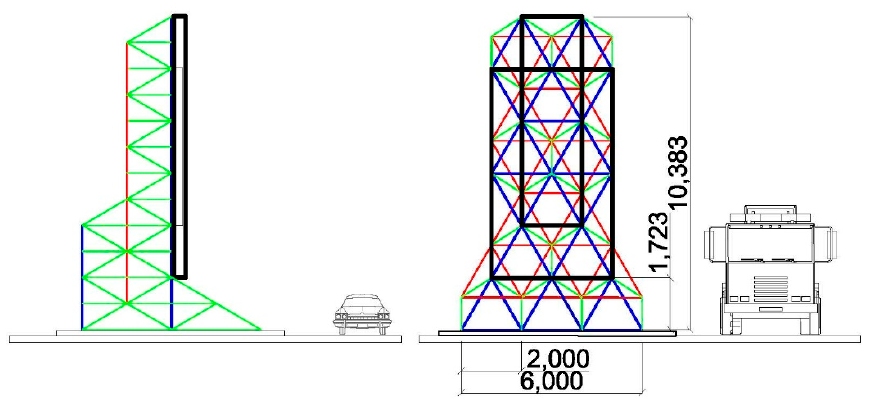
Figure 16. The Diagram (side view, front view) of the rod structure as a support for the information board (Dimensions are given in